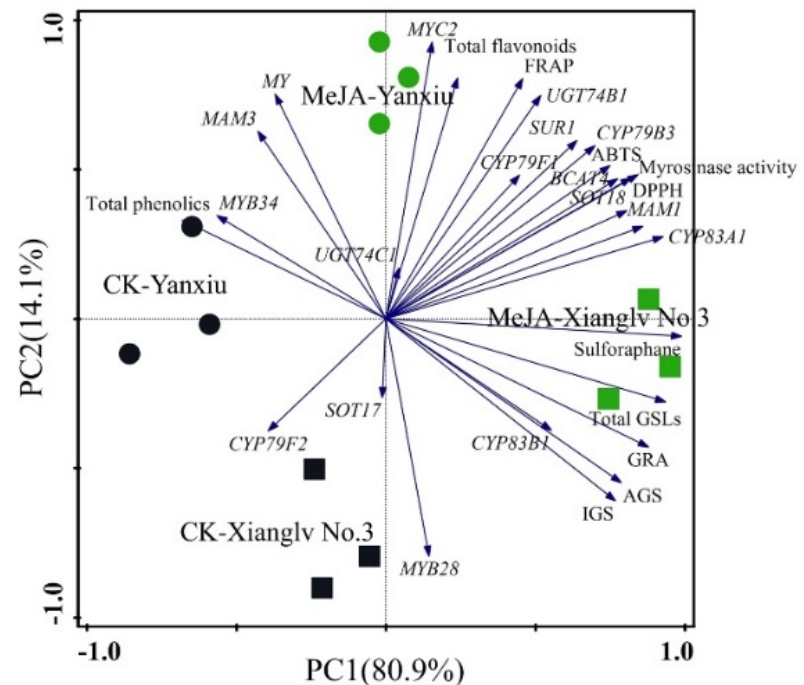
Figure 6. Biplot of the principal component analysis of the observed parameters of broccoli florets